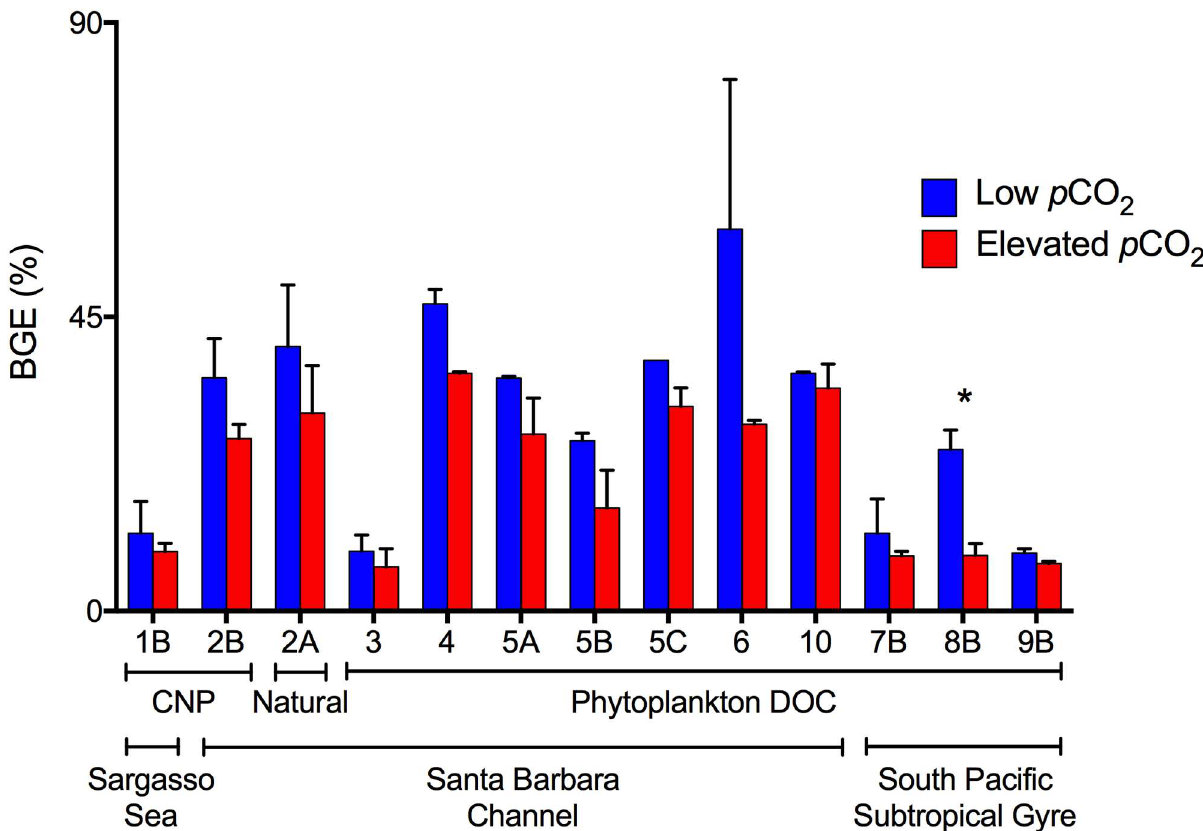
Fig 6. Bacterioplankton growth efficiency. Mean ( ± SD) Bacterioplankton growth efficiencyaveragedacross duplicateincubationsand calculatedas the changein bacterioplankton biomass carbon (usinga carbon conversionfactor of 30 fg C cell -1 for bacterioplanktonin the Santa BarbaraChanneland 10 fg C cell -1 for bacterioplankton in the Sargasso Sea and South Pacific SubtropicalGyre) dividedby the concurrent changein DOC from T 0 to stationary phase. Colors denotebacterioplankton growth efficiency at elevated p CO 2 (red) and low (ambient or pre-industrial) p CO 2 (blue). Numbers refer to the experiment number (Table 1). Only experiments where a changein TOC was resolvableare shown.